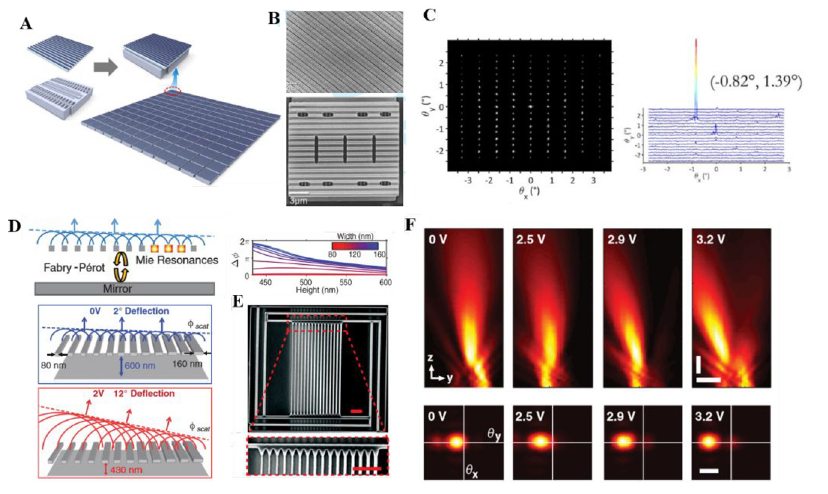
individual dielectric antenna. Meanwhile, this Mie reso- nance is coupled with the Fabry Perot resonance that exists between the substrate and nanowire array. A 2 π re fl ection phase can be controlled over a broad range by tuning the gap, where the interplay between the Mie and Fabry – Pérot resonances is manipulated. The SEM image of the Si nano- wire array is in Figure 6E. The actuating voltage of 3.2 V decreases the gap and therefore the diffracted beam is continuously redirected from 2 ° to 12 ° . The beam pro fi les and their Fourier images in the angular space are shown in Figure 6F. The operation frequency is expected to be as high as 1 MHz. This device does not degrade noticeably after 10 9 cycles, showing excellence robustness. This is also a ver- satile platform, which can also realize the temporal color mixing and light focusing by varying nanowire designs.